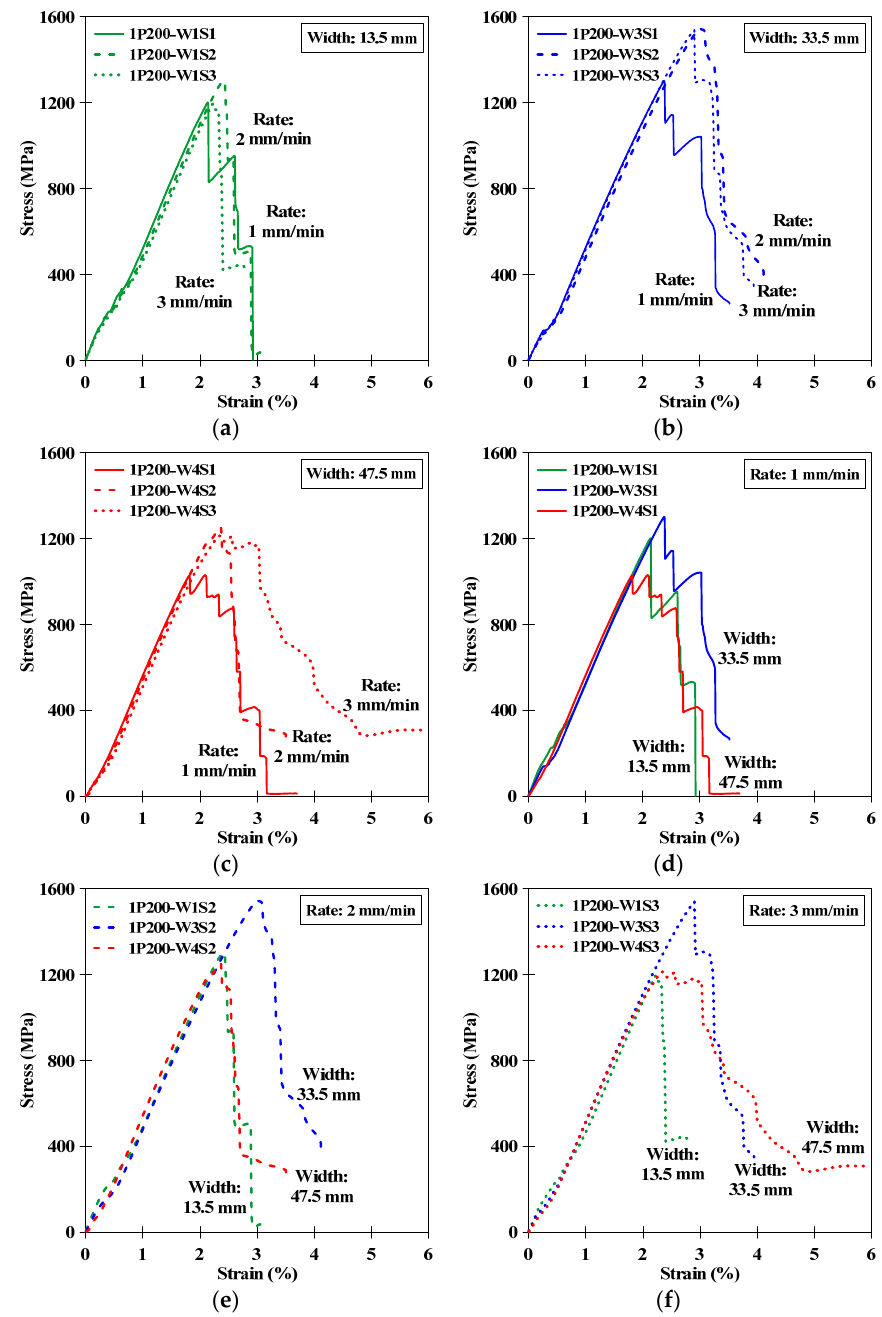
Figure 8. Stress–strain results of the 200 mm long specimens that were clamped using rough paper: ( a – c ) comparison between different displacement rates and ( d – f ) comparison between strips with different widths. Table 3. Results of the basalt grid strips tested without the video-extensometer.